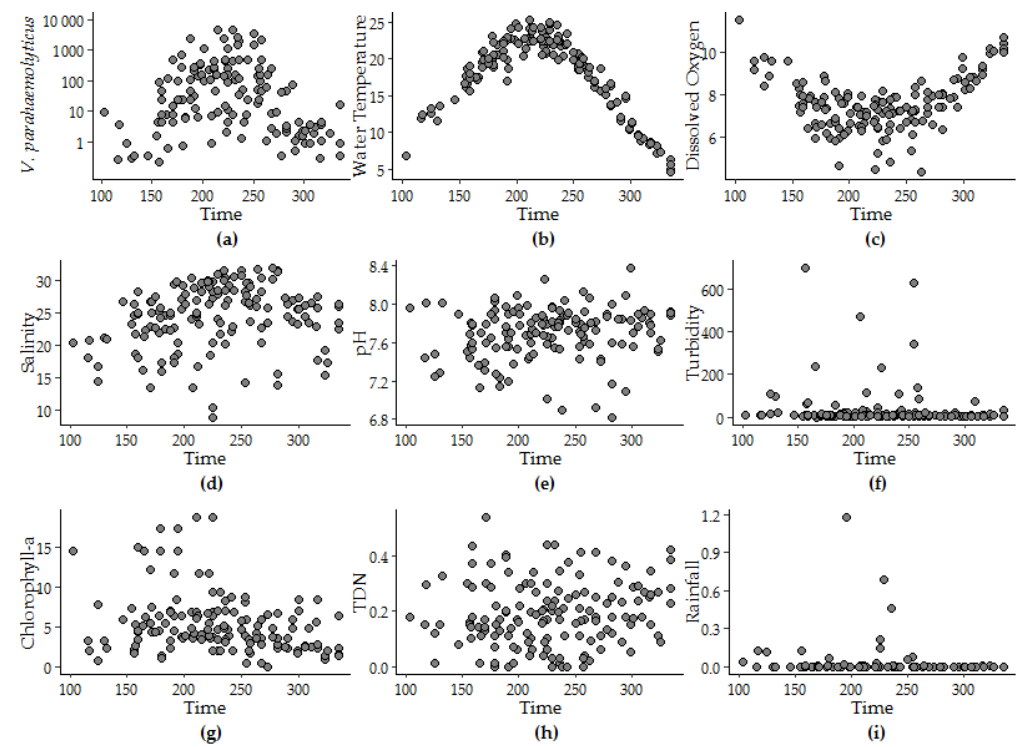
Figure 3. Patterns in ( a ) V. parahaemolyticus concentration, ( b ) water temperature, ( c ) dissolved oxygen, ( d ) salinity, ( e ) pH, ( f ) turbidity, ( g ) CHL, ( h ) TDN, and ( i ) rainfall versus the calendar day of the year superimposed from 2007 to 2016.